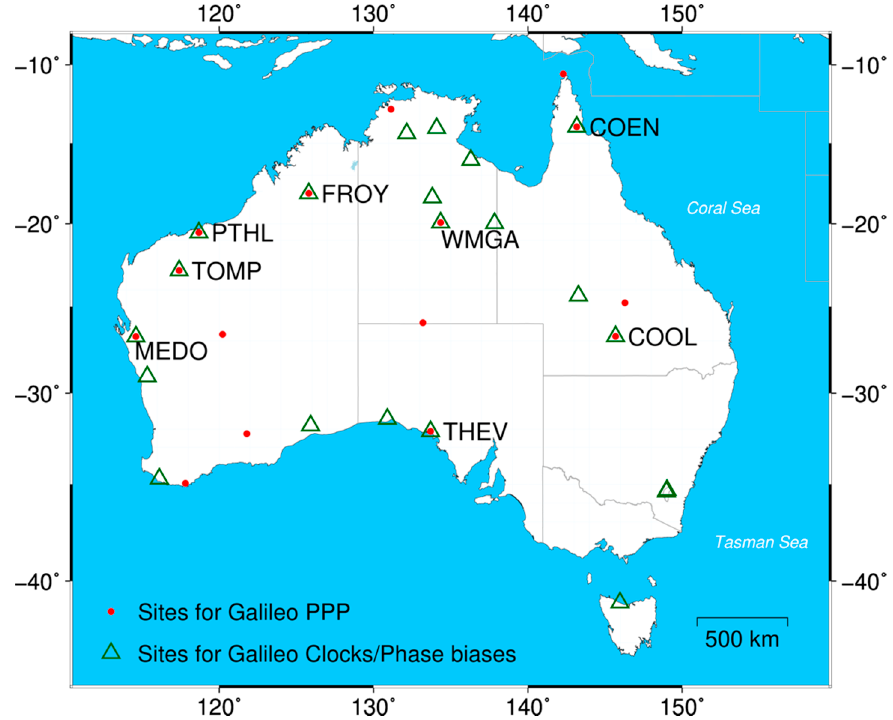
Figure 2. Distribution of stations. There are 15 stations with red dots are used for Galileo kinematic PPP, and 21 stations with dark green triangles are used for the estimations of Galileo satellite phase biases and clocks. The stations used for PPP and product estimation are shown with the site code.